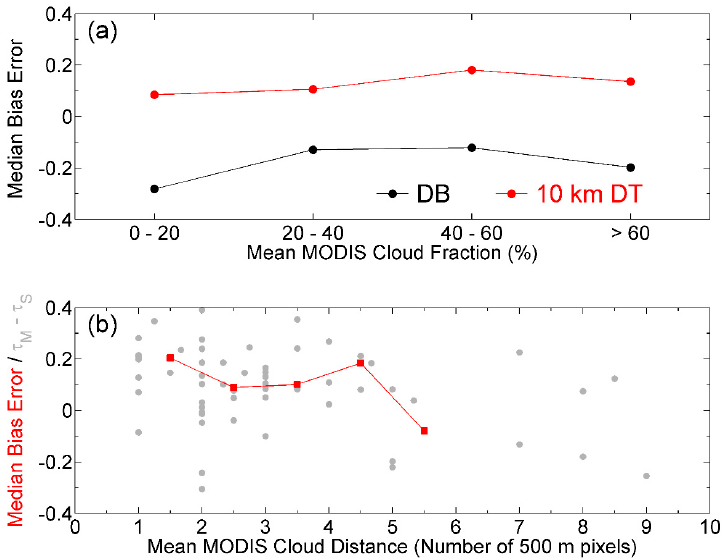
Figure 5. The median biases between the MODIS and sun photometer AODs in different bin of ( a ) the mean cloud fractions for the DB and 10 km DT algorithms and ( b ) the mean cloud distances for the 10 km DT algorithm. In the lower panel, the AOD differences of individual matchup are presented as gray dots and the red squares are median biases for the mean cloud distances less than 2, within 2–3, 3–4, 4–5 and equal to or larger than 5. Only the datasets with all quality of Aqua are included.